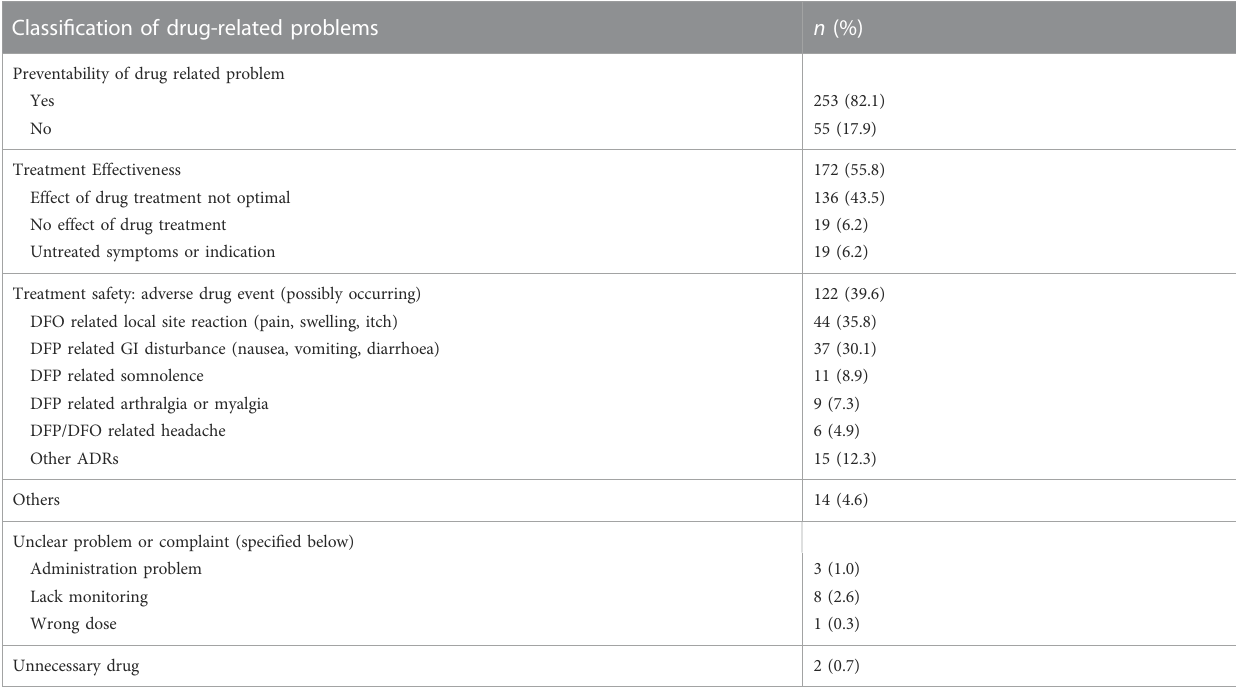
TABLE 3 Summary breakdown of drug related problems encountered ( n =